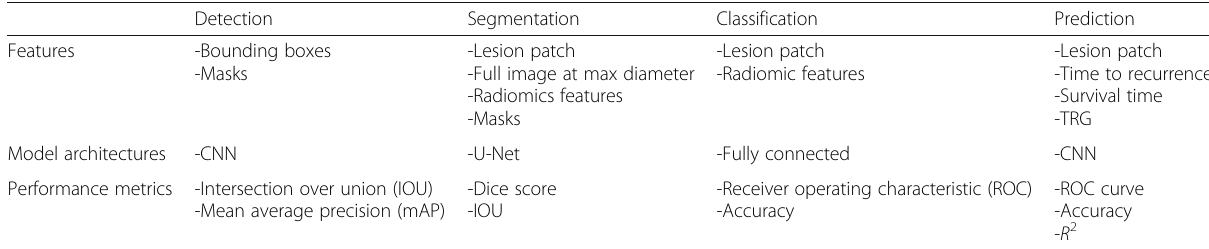
Table 2 Examples of reference standards, common performance metrics, and model selection for various